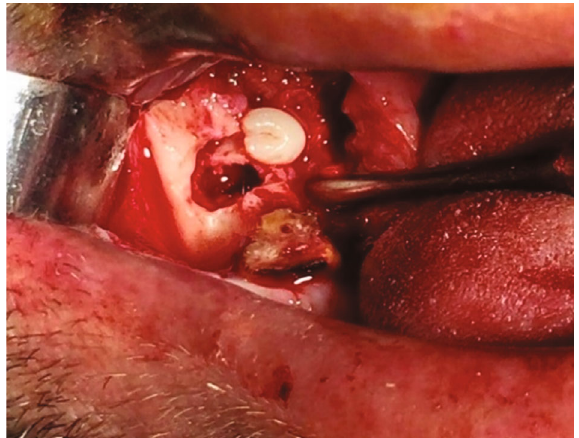
Figure 4: Exposed ectopic wisdom